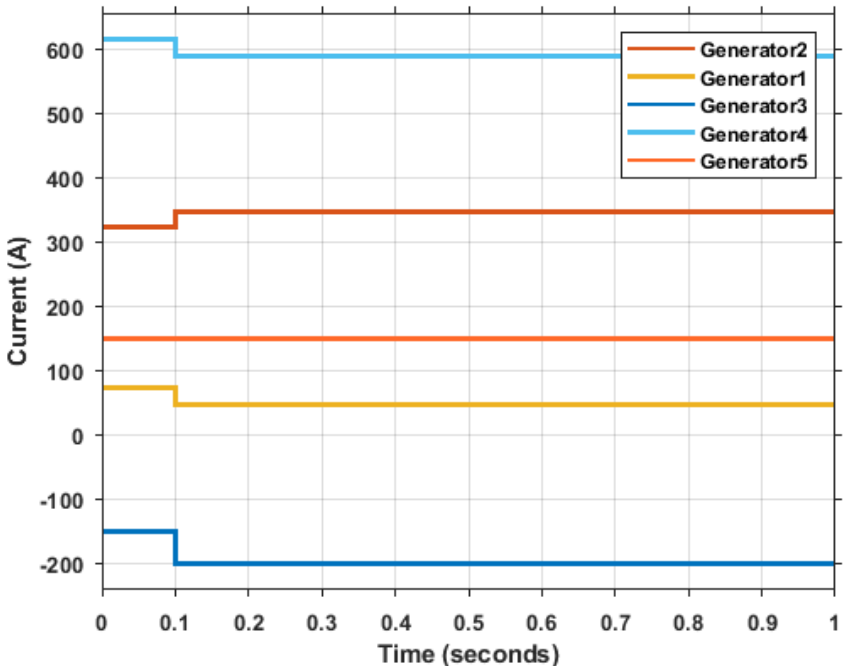
Figure 19. Currents from the DC microgrid generators before/after connecting a normal conductor. Table 4. Comparison between the performance of the DCSOP and the normal conductor in terms of the change of branch currents.